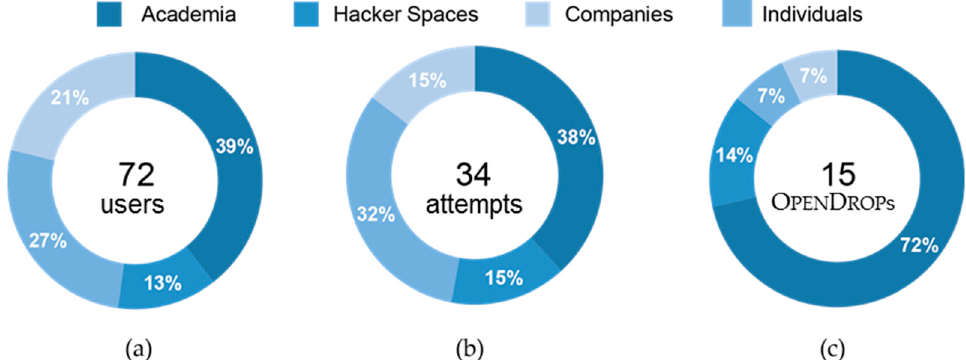
Figure 13. Our user base has 72 members, out of which 34 have tried to replicate O PEN D ROP . A total of 15 users (47%) succeeded to replicate our platform. We show the distribution of users by occupation for ( a ) the total user base; ( b ) the number of users that attempted to replicate O PEN D ROP ; and ( c ) the users that succeeded to replicate O PEN D ROP .